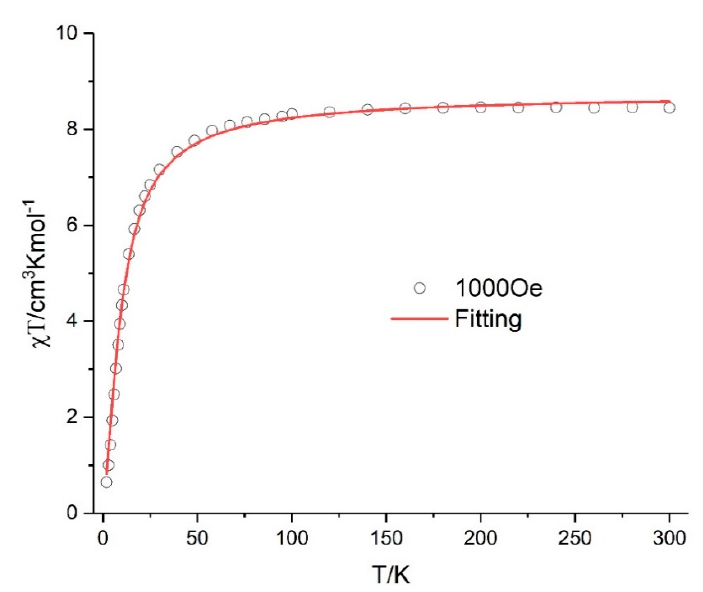
Figure 5. Plot of χ T vs. T for Na-1 under 1000 Oe applied dc field. Solid line for fitting.